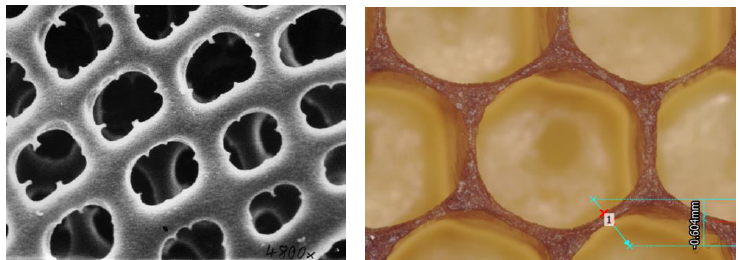
Figure 9. High magnification images of cells comprising a radiolaria ( left , attr: Hannes Grobe, Wikimedia Commons) and honeycomb ( right ). Clearly visible are nuances such as the corner radius and variations in the beam thicknesses.